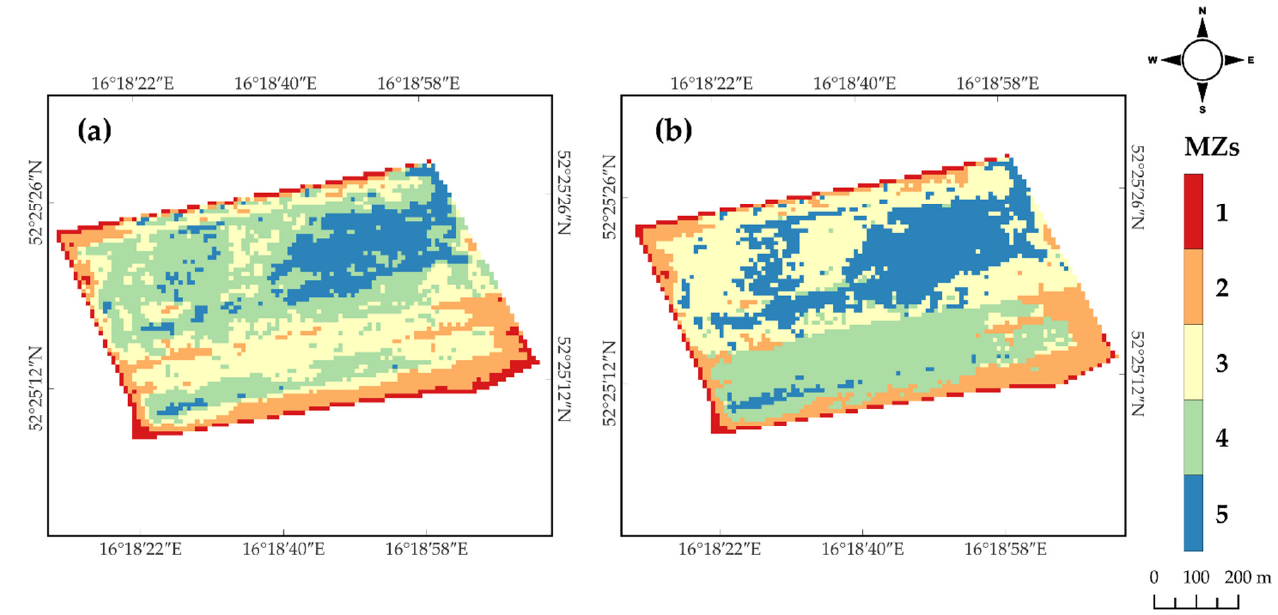
Figure 13. Delineated MZ maps of model-3 for fertilization at 25 March 2020 ( a ) and 21 April 2020 ( b ).